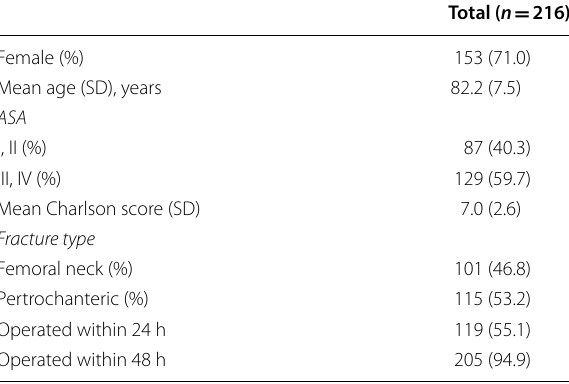
Table 1 Baseline characteristics